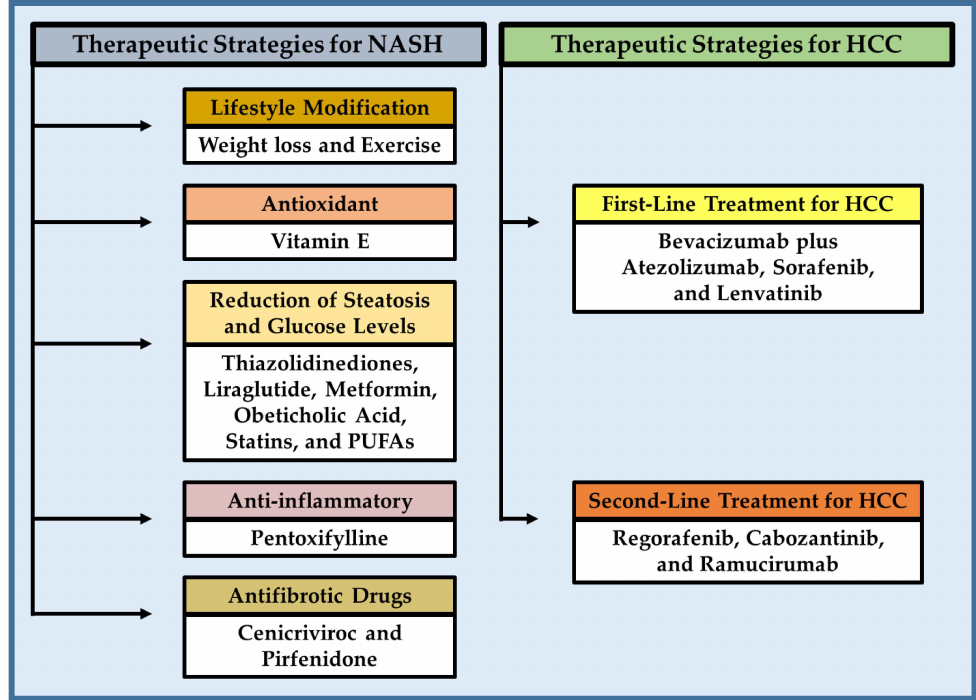
Figure 5. Different therapeutic strategies for NASH and HCC. Abbreviations: PUFAs, omega-3 polyunsaturated fatty